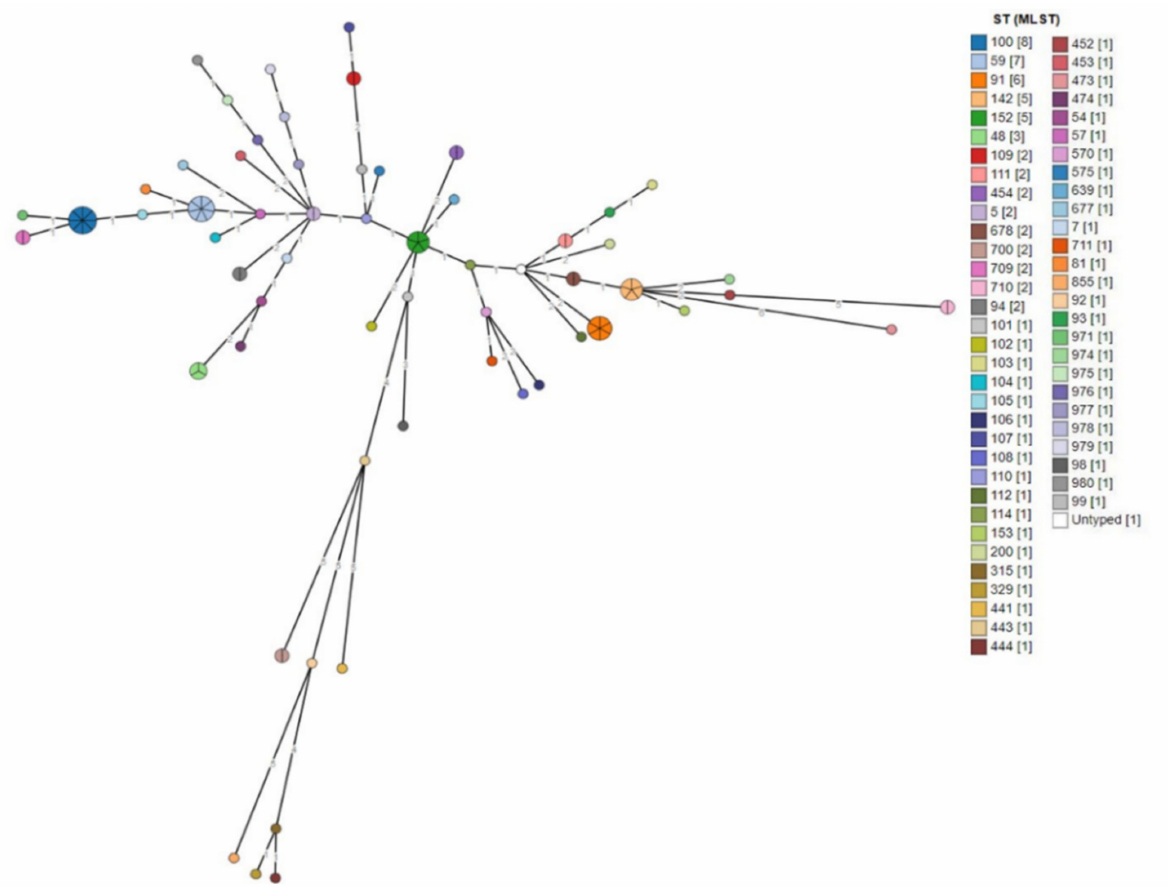
Figure 4. MLST-based spanning tree of S. epidermidis isolates from cases of mastitis in the MLST database ( n = 97) according to the ST (drawn by using the Grape-Tree application). Each colour corresponds to an ST, the number in brackets corresponds to the number of isolates distributed into that ST, the colour of each node corresponds to the ST included in it and the number within the edges (i.e., branches) indicates the allelic distance. MLST: multi-locus sequence typing; ST: sequence